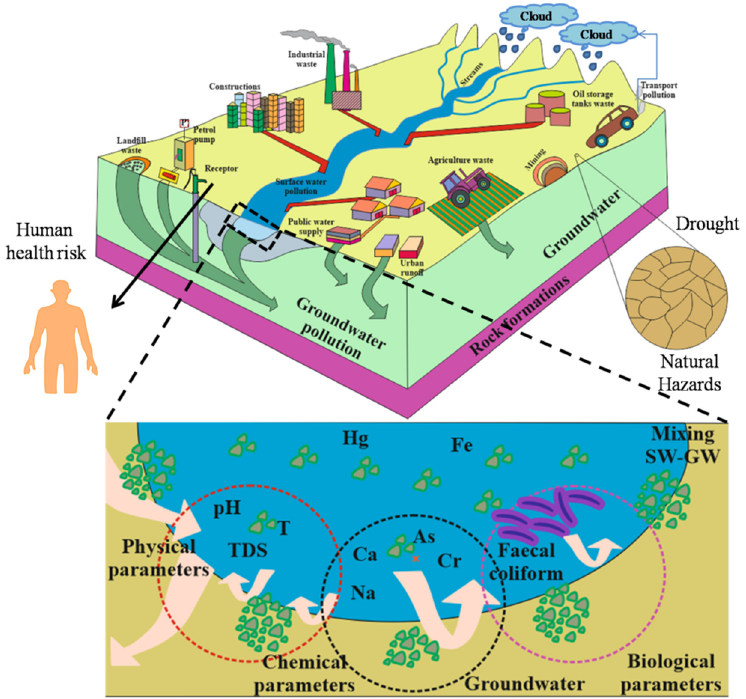
Figure 1. Shows the quality of surface water and groundwater resources degrading by anthropogenic and natural processes from various sources, as well as the effect on human health through these